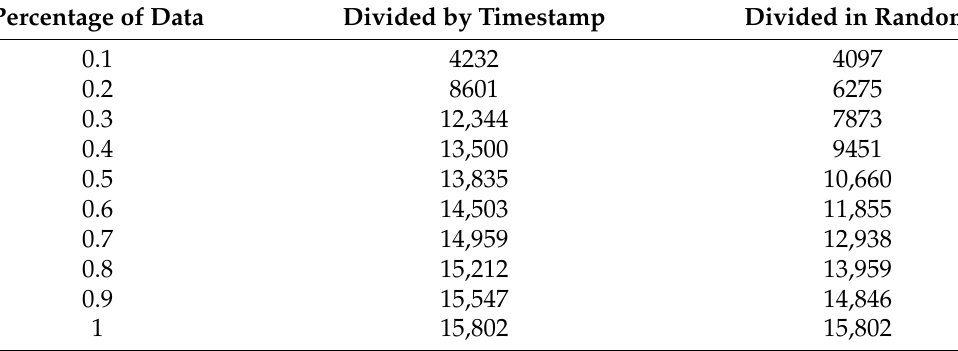
Table 5. Log types distribution on HDFS